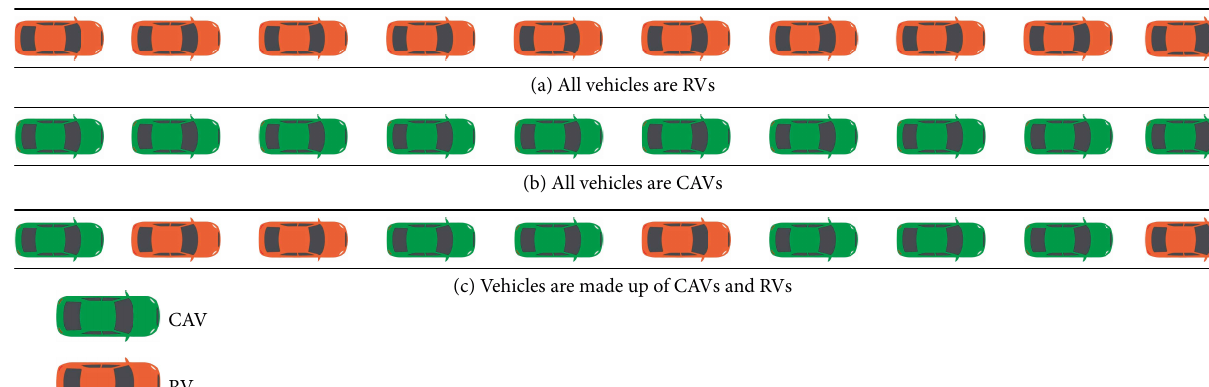
Figure 11: Illustrative distribution of CAVs and